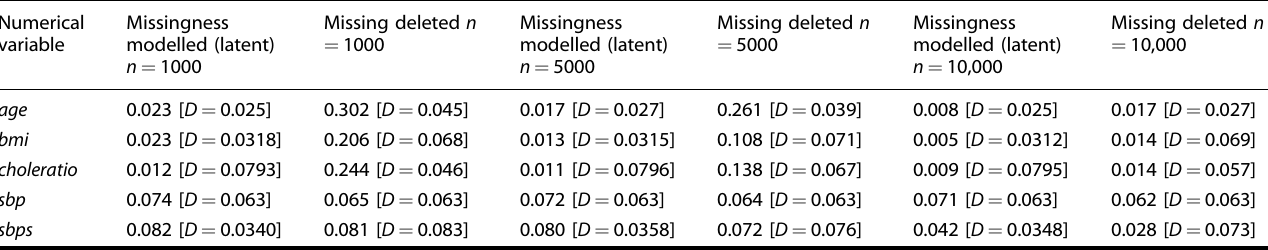
Table 2. KS test p values for the hypotheses of numerical variables for GT and SYN data sets are from the same distribution and the associated D statistic of the test. Numerical